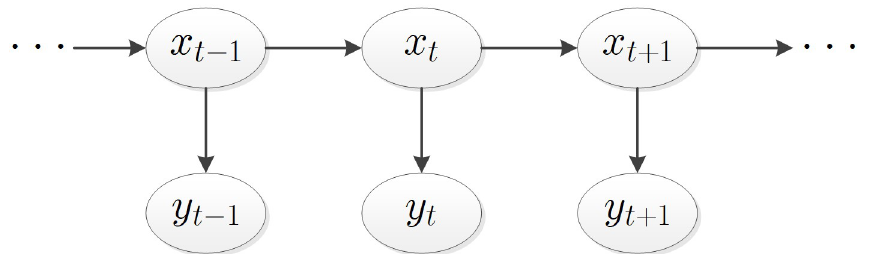
Fig 1. Evolution of HMM